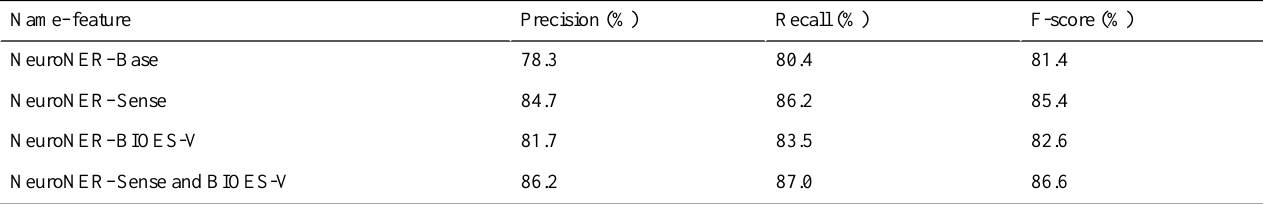
Table 14. Feature evaluation on the BioScope Task 1W test data